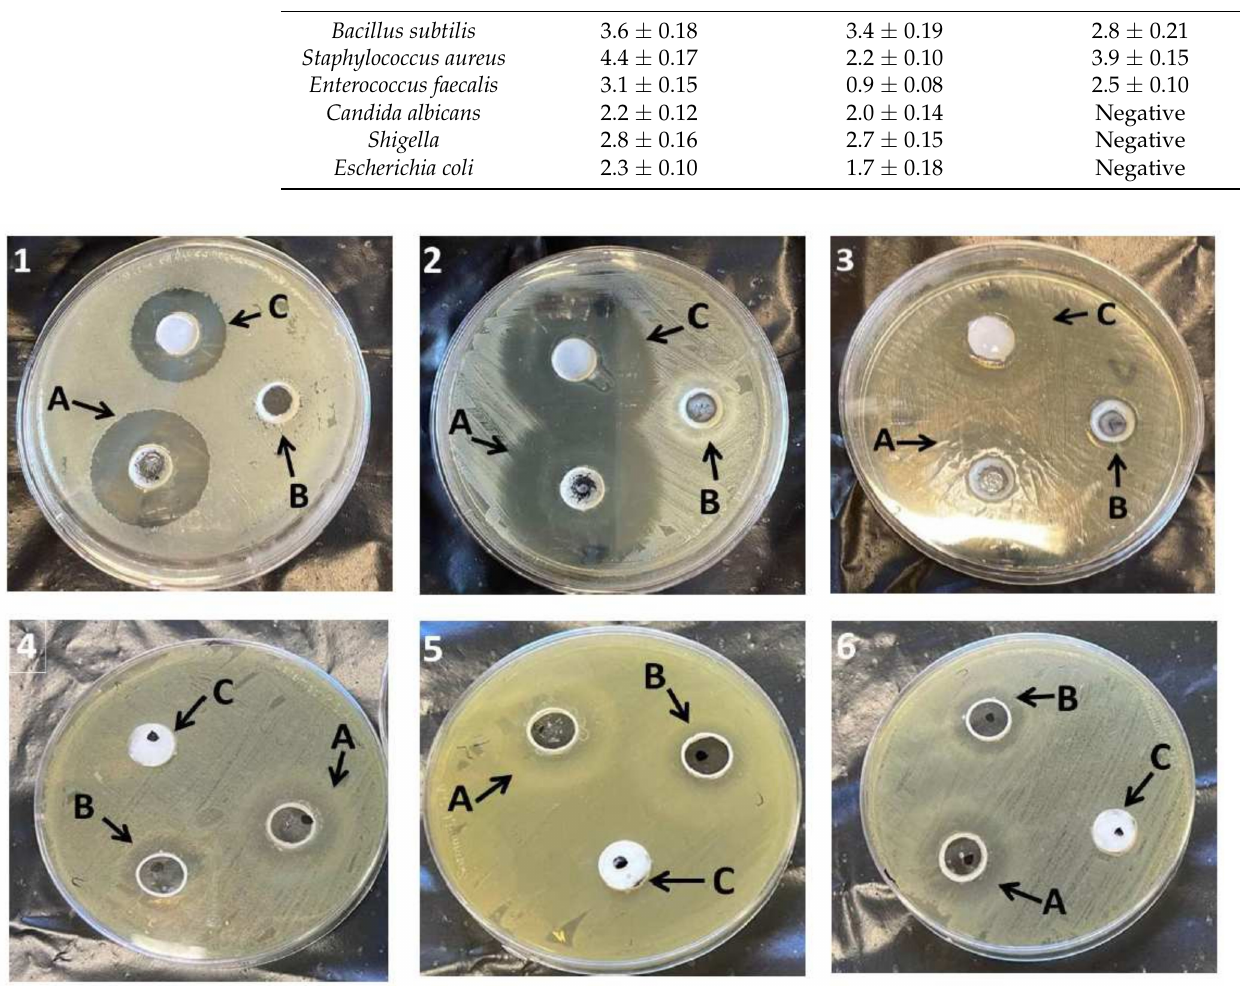
Figure 13. Inhibition zone diameters caused by various formulations—( A ) FA-NEG, ( B ) placebo NEG, and ( C ) marketed FA—on different organisms: ( 1 ) Bacillus subtilis , ( 2 ) Staphylococcus aureus , ( 3 ) Enterococcus faecalis , ( 4 ) Candida albicans , ( 5 ) Shigella , and ( 6 ) Escherichia coli